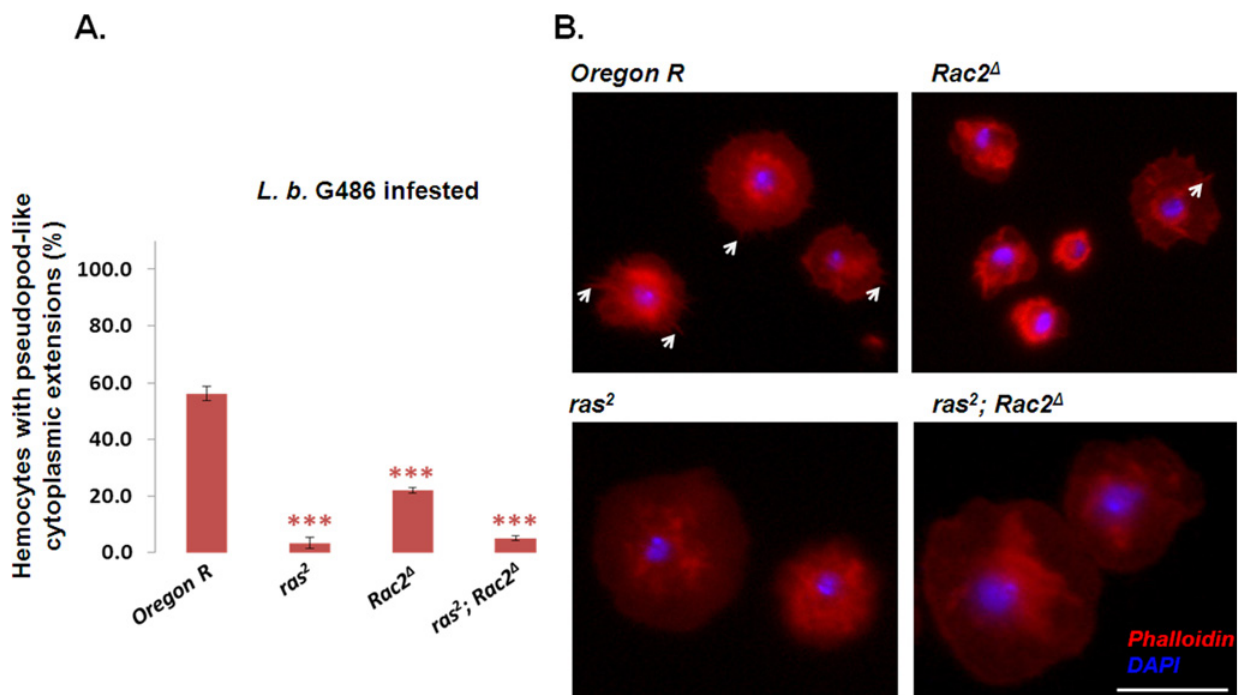
Fig 5. Formation of pseudopod-like cytoplasmic extensions in hemocytes. (A) The proportion of the filopodia-like extensions in hemocytes. (B) The morphology of circulating hemocytes in immune induced larvae 24 h after infestation. Arrowheads indicate the cytoplasmic extensions in hemocytes. The statistical analysis was performed counting at least 100 hemocytes derived from six larvae from each genotype. The experiment was repeated at least three times. The arrows show phalloidin-binding cytoplasmic extensions. The error bars indicate the standard error of the mean *** p < 0.001. The scale bar indicates 20 μ